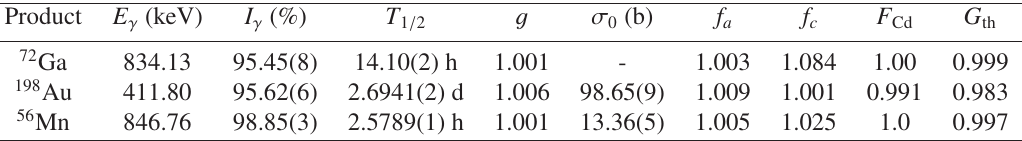
Table 1. Decay data (gamma energy E γ , gamma intensity I γ , half-life T 1 / 2 )[20–22], thermal constants (Westcott factor g , thermal cross section σ 0 [23]), gamma attenuation factor f a , coincidence summing correction factor f c , Cd transmission factor F Cd [24], and thermal self-shielding factor G th adopted in our work. The value of the uncertainty in parenthesis applies to the least significant